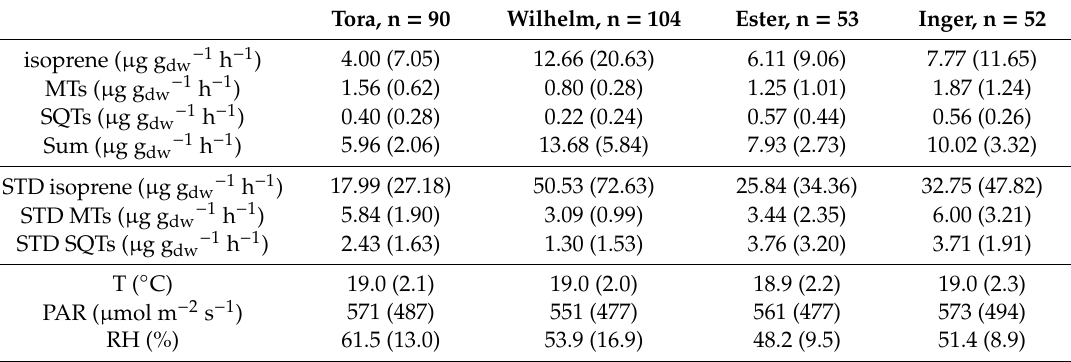
Table 5. Upper part: Isoprene, monoterpene (MT), sesquiterpene (SQT) and total terpenoid emissions ( µ g g dw − 1 h − 1 , mean ± standard deviation) for the di ff erent Salix varieties. Middle part: Standardized (STD) emission rates ( µ g g dw − 1 h − 1 , mean ± standard deviation). Lower part: Average T ( ◦ C), photosynthetically active radiation (PAR, µ mol m − 2 s − 1 ) and relative humidity (RH) (%) in the measurement cuvette.